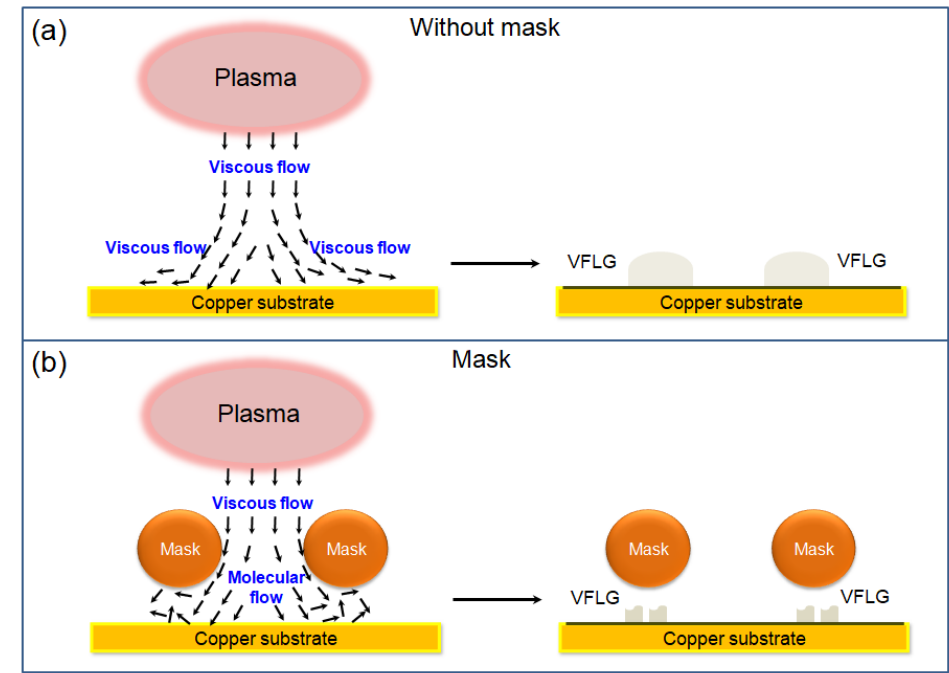
Figure 4. ( a ) Schematic diagrams of VFLG growth without Cu mask which shows a viscous flow on Cu substrate surface; ( b ) schematic diagrams of HCVFLG growth with Cu mask which shows a molecular flow between the Cu mask and Cu substrate.